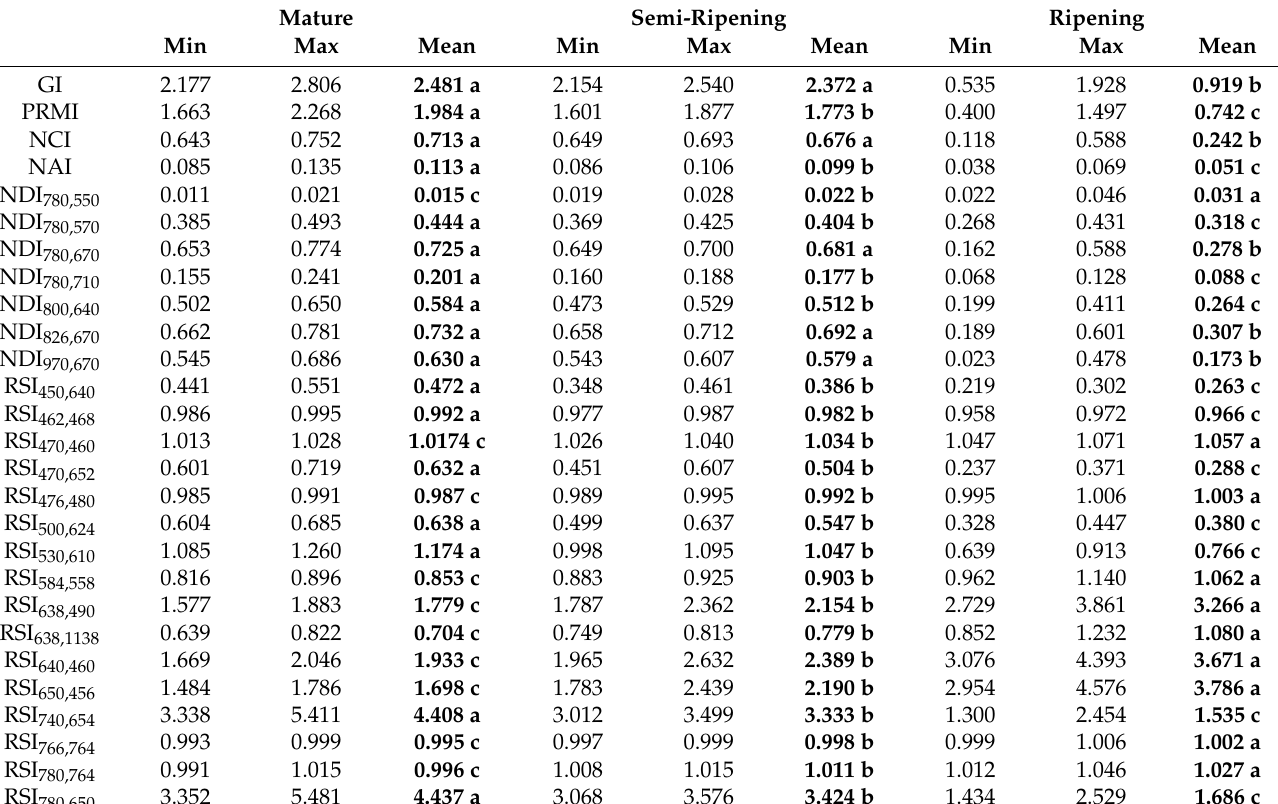
Table 4. Variation in the values of SRIs at different ripening